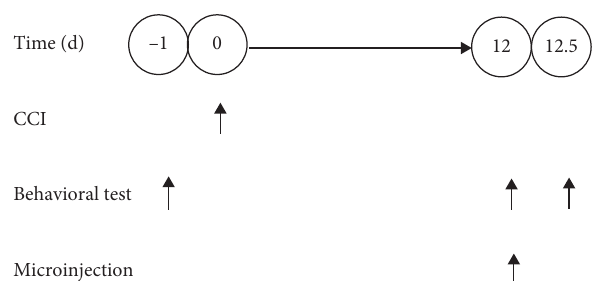
Figure 1: Experimental schedule. One day before the surgery, behavioral testing was performed to eliminate the mice exhibiting hyperalgesia or dysesthesia to pain. 12 days after the surgery, the CCI mice exhibiting hyperalgesia were microinjected with SRT1720, EX-527, or vehicle. 12h after the microinjection, the effect of SRT1720 and EX-527 on neuropathic pain was indicated by behavioral